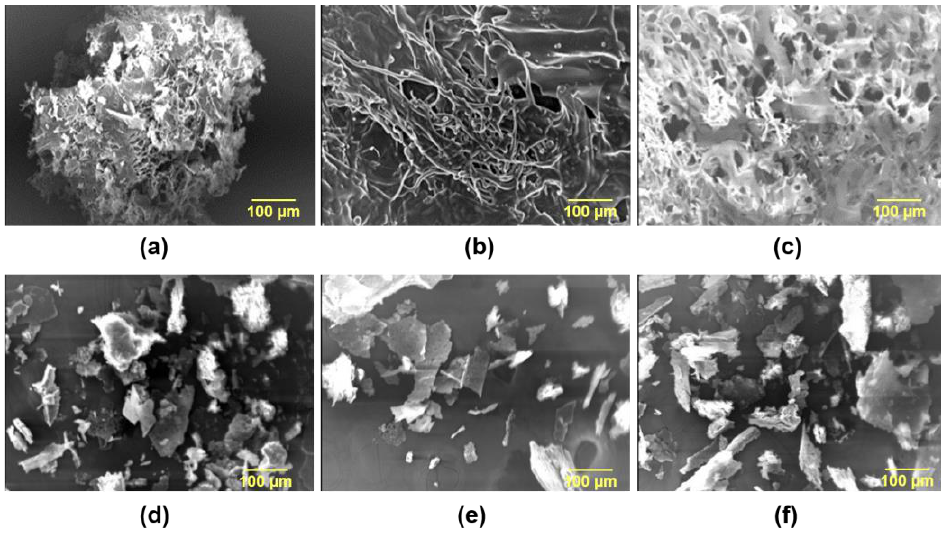
Figure 2. SEM micrographs showing the channels and cross sections of different lyophilized hydrogel systems at a magnification power ( × 100). ( a – c ) The graphs display the hydrogel formulas: ( a ) formula A, ( b ) formula B, and ( c ) formula C. ( d – f ) The graphs display the physical mixtures of the hydrogel components: ( d ) physical mixture of formula A, ( e ) physical mixture of formula B, and ( f ) physical mixture of formula C.